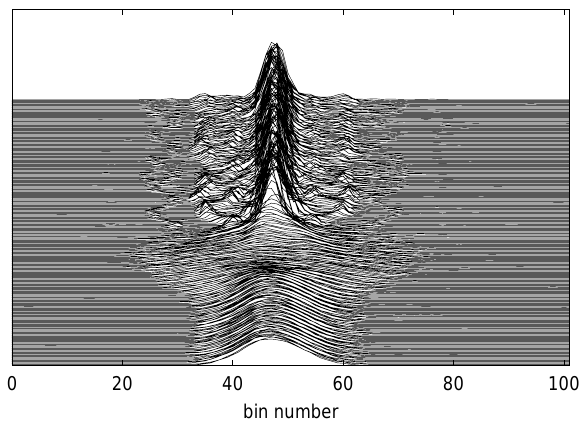
FIG. 3. Mountain range plot comprising 250 profiles obtained using the wall current monitor during the rebucketing of fill 01484 in the RHIC Blue ring. Profiles were acquired every 20 turns.